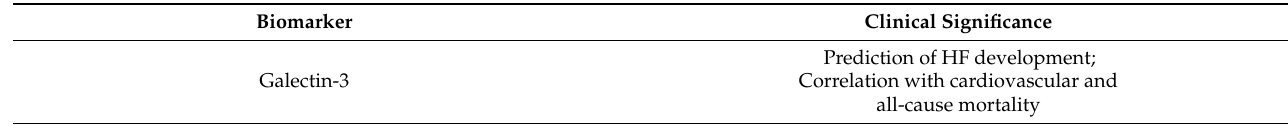
Table 1. Cardiovascular extracellular matrix biomarkers and their clinical